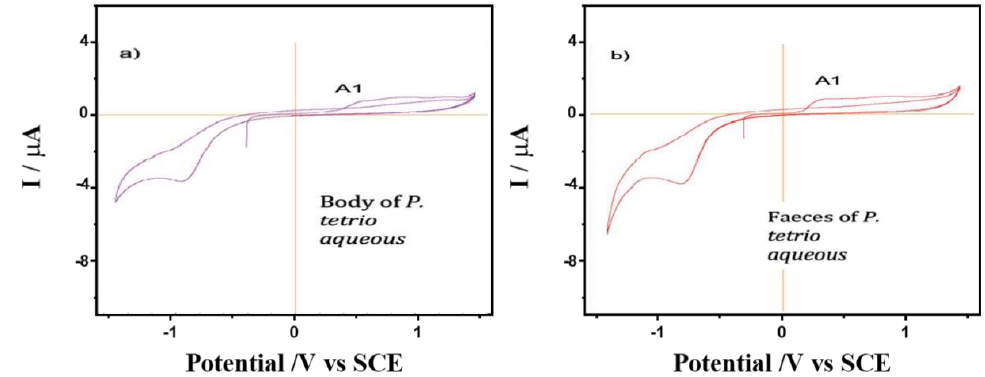
Figure 6. Cyclic voltammograms of films from water extracts of ( a ) P. tetrio ’s bodies and ( b ) its excrement after predation on leaves of A. cathartica on glassy carbon electrode in contact with air- saturated 0.10 M phosphate buffer at pH 7.0. Potential scan rate 10 mV.s -1 .